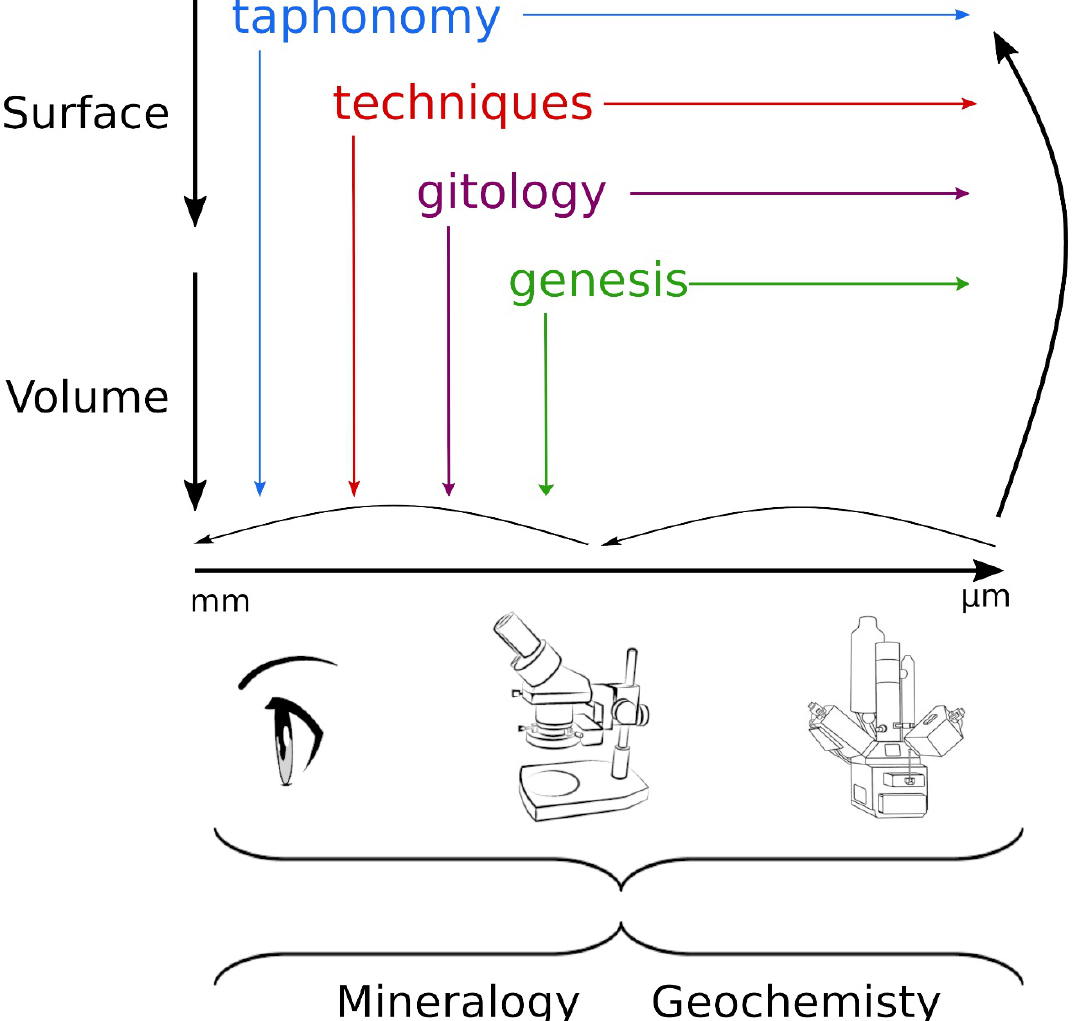
Figure 9. Diagram summarising the methodological approach to access the multiple signatures of colouring matter. Diagram: H.